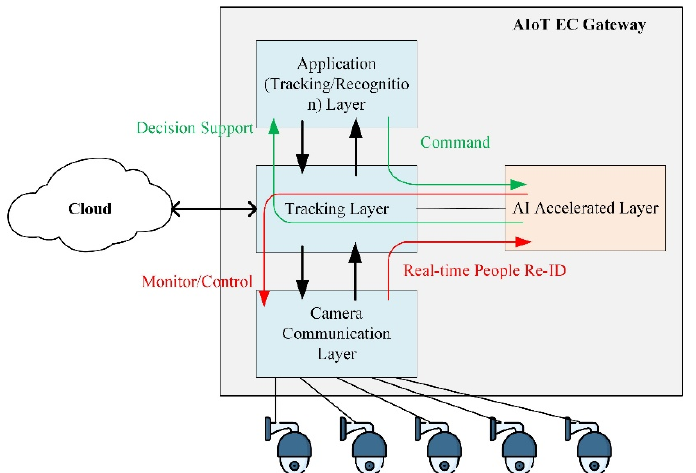
Figure 3. Schematic representation of the person Re-ID microservice over artificial intelligence internet of things (AIoT) edge computing (EC) gateway.